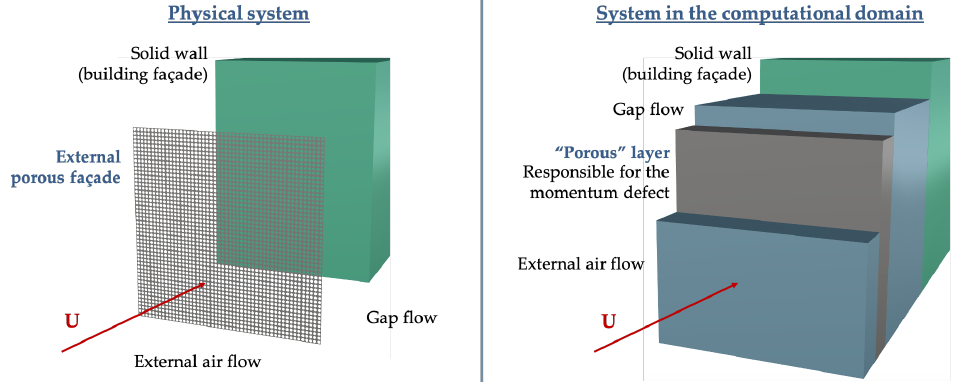
Figure 8. Schematic view of the reduced order modelling of the porous layer: comparison between the physical system ( left ) with the PDSF system in the computational domain ( right